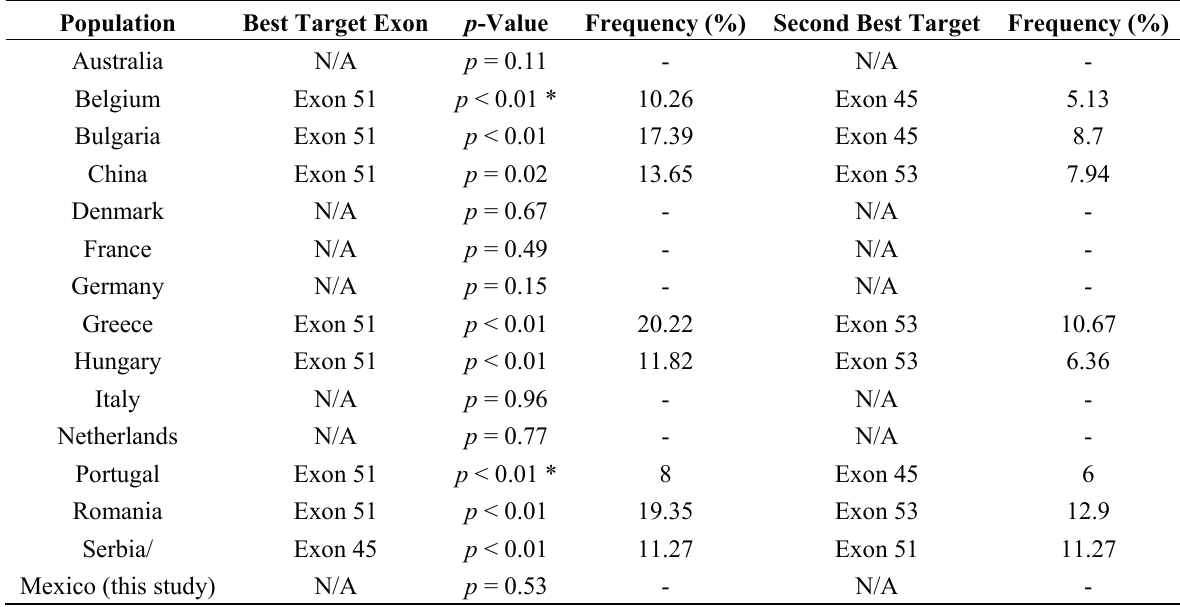
Table 4. Comparison of targets for exon skipping by population (intra-population